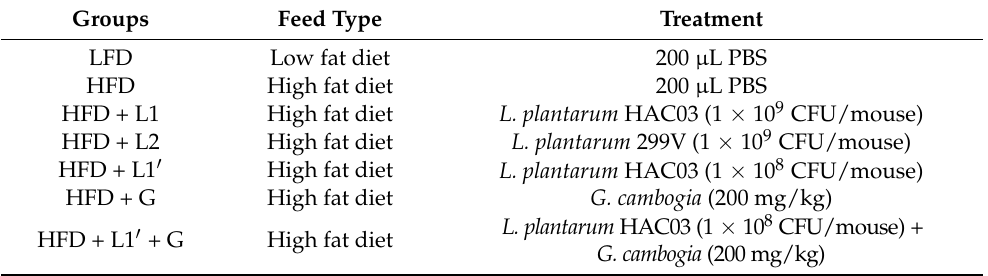
Table 1. All groups of animal experiments.